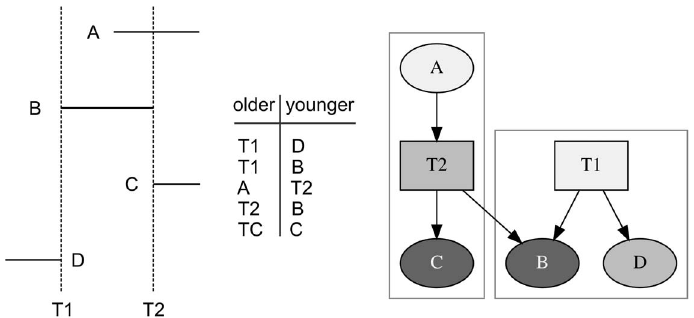
Figure 6. Unilaterally connected subgraphs of a weakly connected directed graph. Left , map showing trails T1 and T2 with agricultural walls A , B , C , and D ; middle , table of the chronological relations shown in the map; right , picture of a directed graph of the chronological relations, where ovals represent agricultural walls, rectangles represent trails, and arcs point from an older feature to a younger one. The gray rectangles enclose unilaterally connected subgraphs. Note that agricultural wall B belongs to both subgraphs, but the picture shows it in only one.